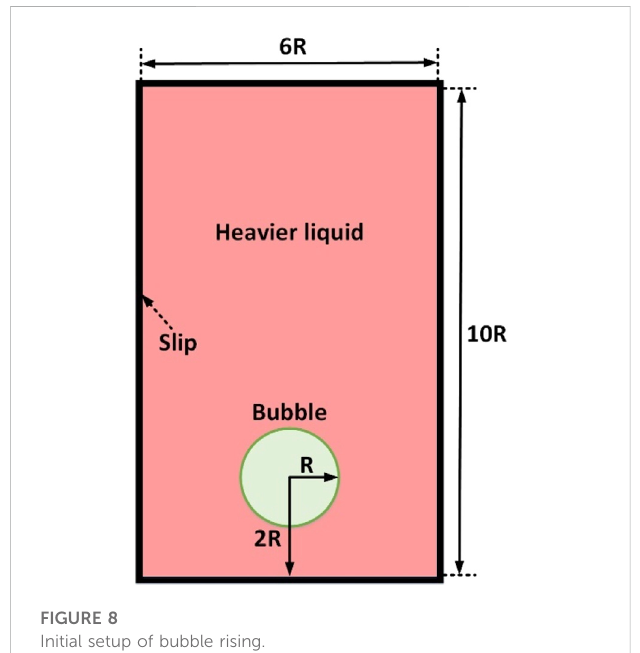
FIGURE 8 Initial setup of bubble